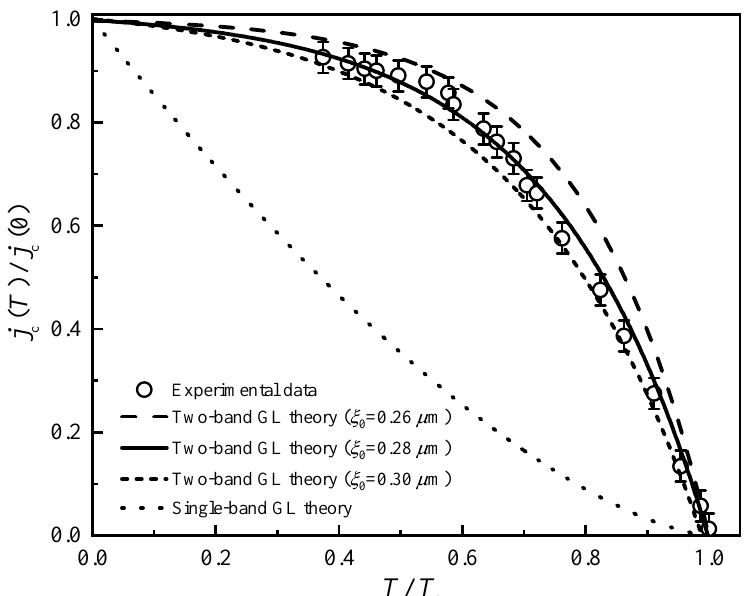
Figure 4. The temperature dependence of critical supercurrent density for the NbSe 2 thin film. The experimental data of the 2.0 nm thick NbSe 2 film are taken from Ref.